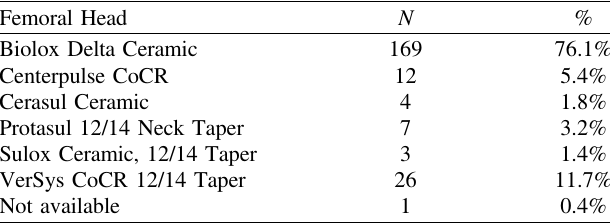
Table A.1. Different femoral head